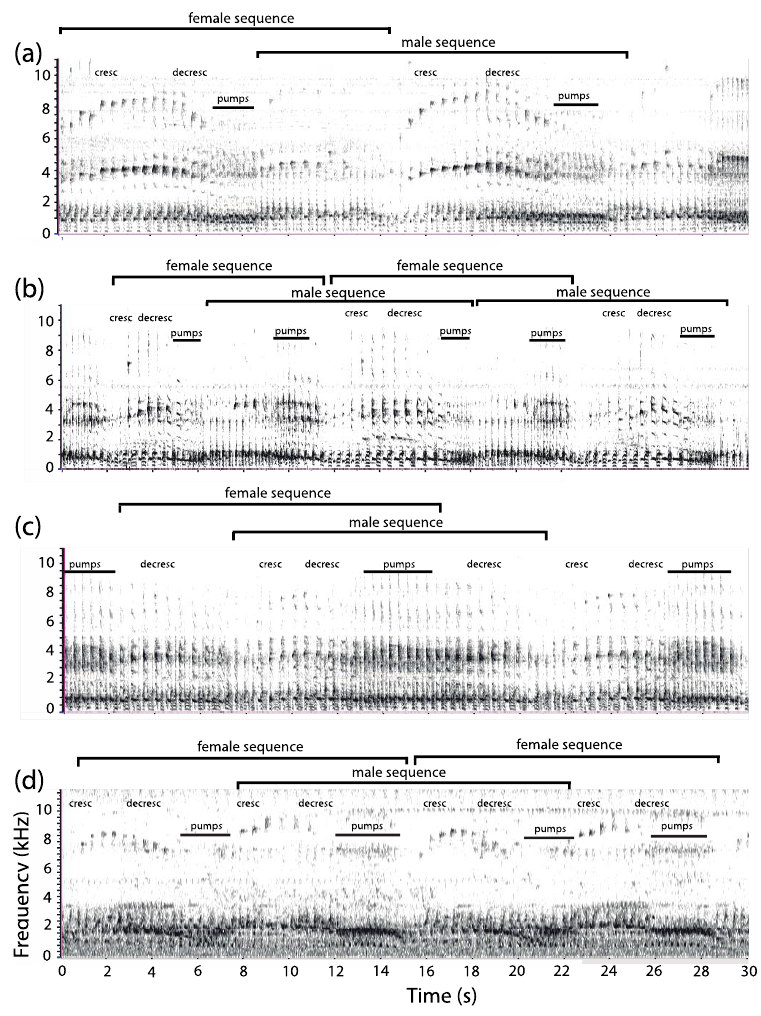
Figure 6. Periodic vocal duets produced in the moloch lineage. ( a ) Plecturocebus discolor , ( b ) P. aureipalatii , ( c ) P. toppini , and ( d ) P. urubambensis . Shown in each panel are overlapping male and female sequences beginning at the onset of each pant phrase. Long series of ascending and descending bellows that culminate with pumping typify the duets in the moloch lineage.